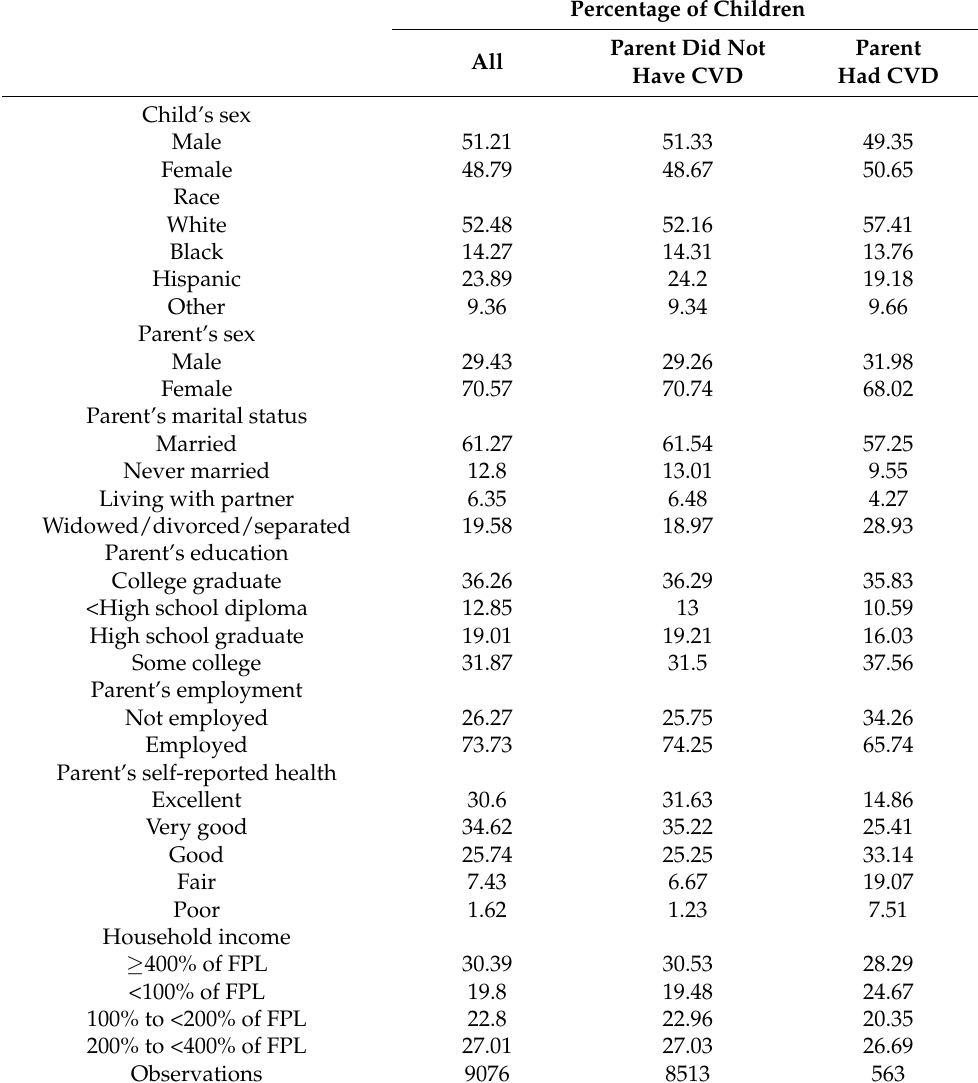
Table 1. Descriptive